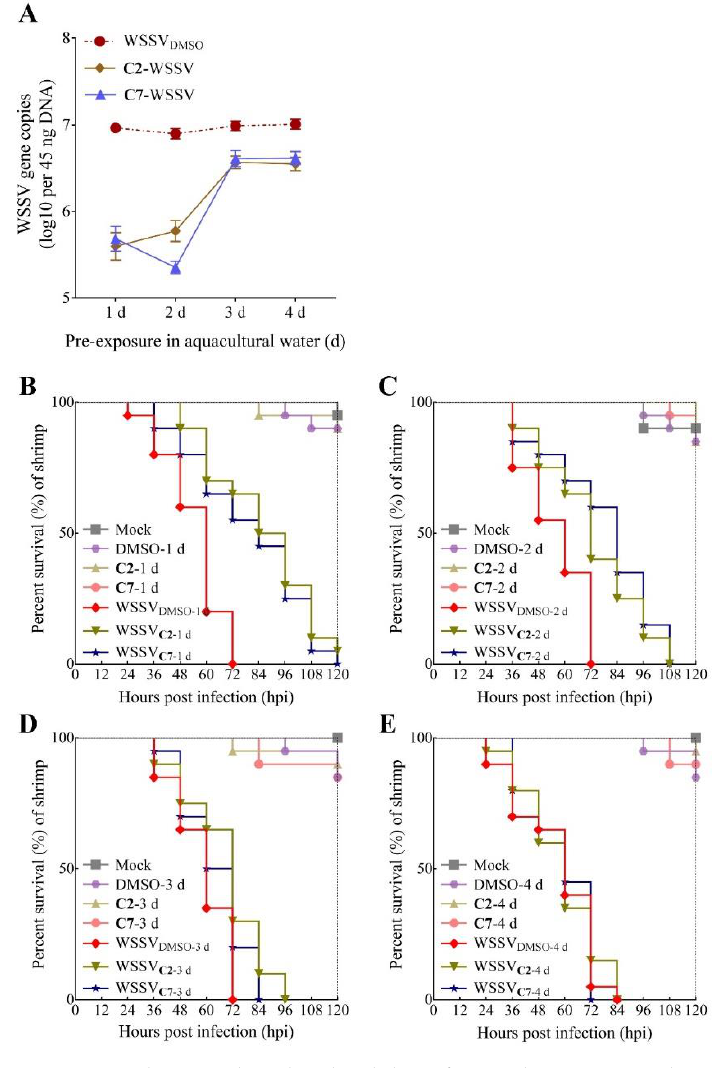
Figure 5. Analysis on the related stability of C2 and C7 in aquacultural water at 28 °C. ( A ) Quantification on copy number of viral genome in shrimp larvae was tested in C2 and C7 for different water samples by RT-qPCR. Each value is represented as the mean ± SD normalized to values for no treatment. ( B – E ) Survivorship curve of WSSV-infected shrimp was analyzed in C2 and C7 at the concentration of 10 mg/L in 1, 2, 3, and 4 d water samples.